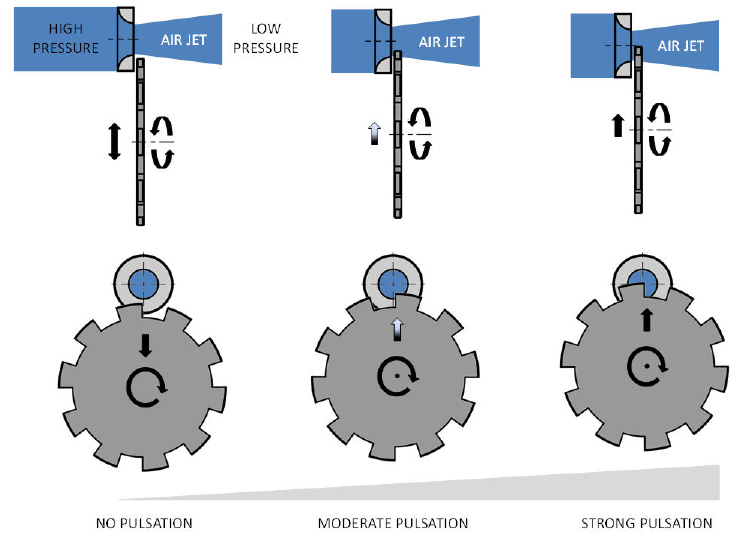
Figure 5. Principle of changing the amplitude of pulsation by moving the position of the cogged wheel’s shaft relatively to the nozzle.